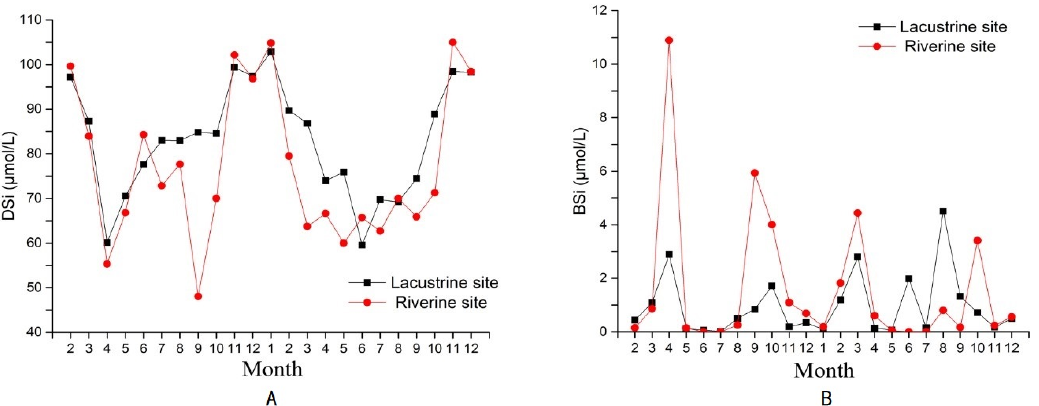
Figure 3. Monthly DSi ( A ) and BSi ( B ) variation (mean value, n = 21 for lacustrine site, n = 6 for riverine site in each month) from February 2015 to December 2016. Spring: March ~ May; Summer: June ~ August; Autumn: September ~ November; Winter: December ~ February.